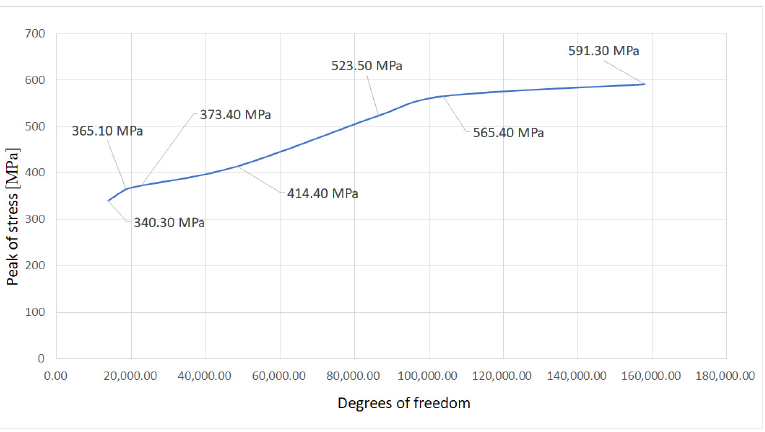
Figure 25. Selection of the optimal convergence value.